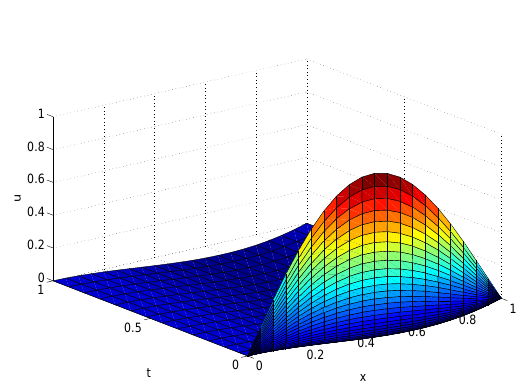
Figure 2: Numerical solution with ε = 10 −2 for Example 4.1